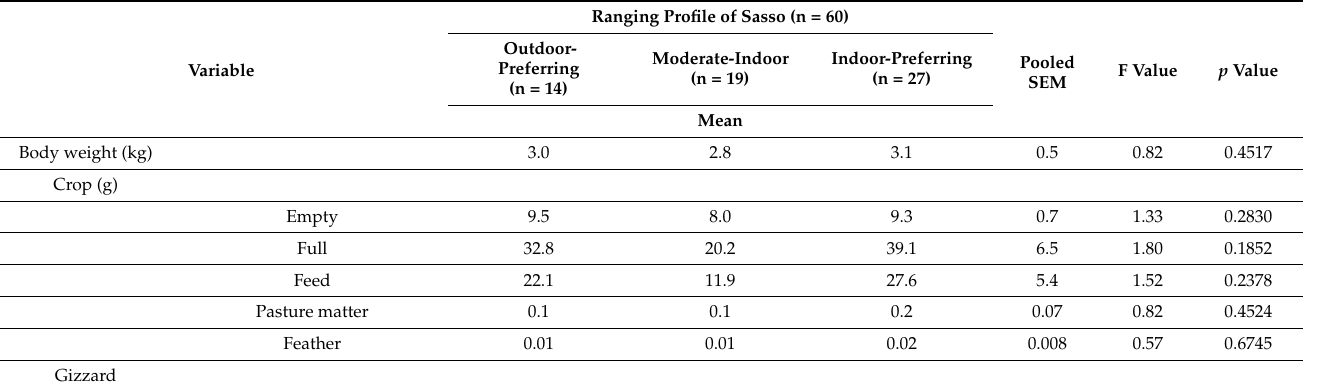
Table 2. The gastrointestinal tract morphometrics and content of Sasso chickens with differing ranging profiles, presented as mean ± SEM and its associated test